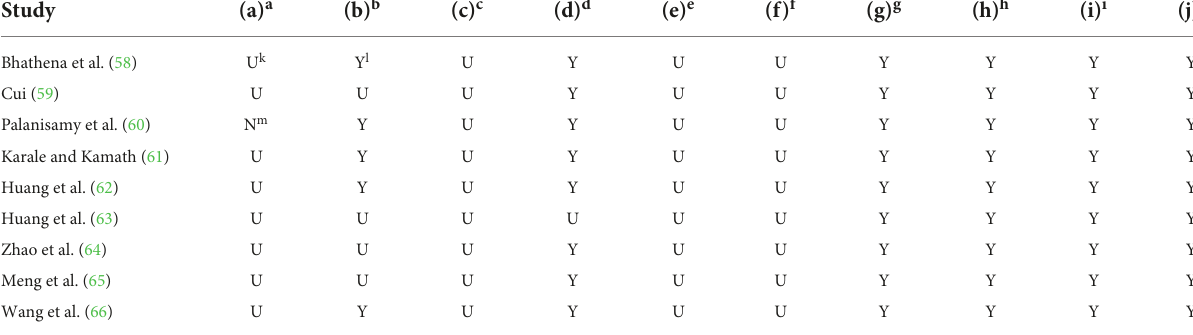
TABLE 4 Risk of bias of included animal